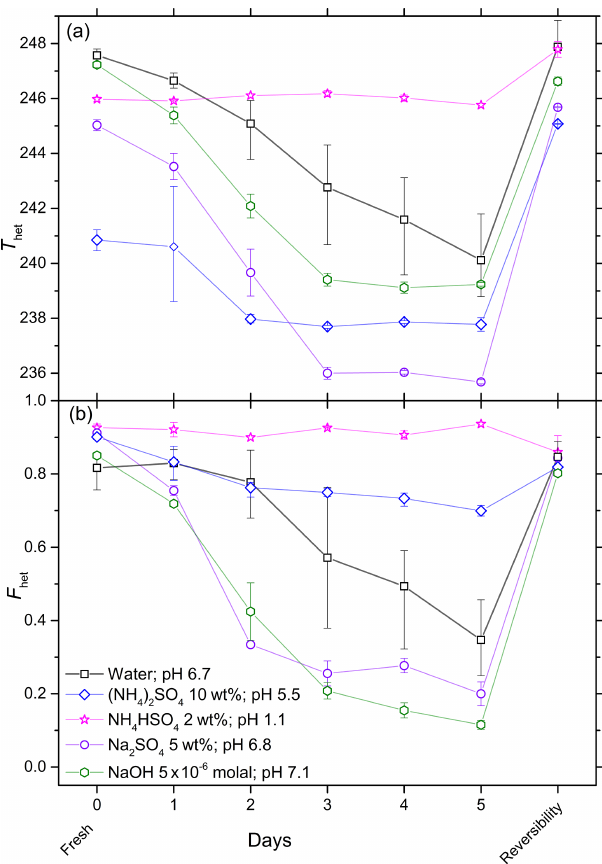
Figure 6. Same as Fig. 5, except that it shows a comparison of IN efficiency of SA quartz (5wt%) suspended in water/aqueous so- lutions (NH 3 0.005molal with pH7.9 and NaOH 5 × 10 − 3 molal with pH9.5) prepared in borosilicate glass vials (open symbols) and polypropylene Falcon tubes (solid symbols). After 5 days aging the reversibility was tested as explained in Fig.